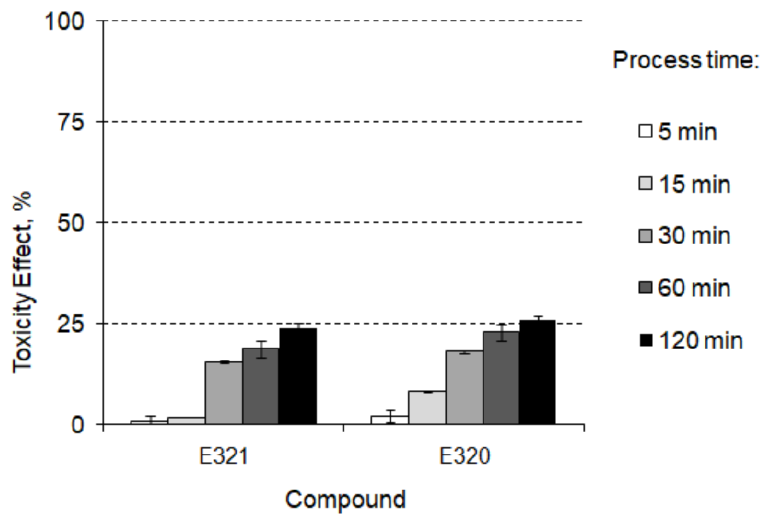
Figure 5. The toxicity change in the by-product formation pathway in swimming pool water instal- lation.